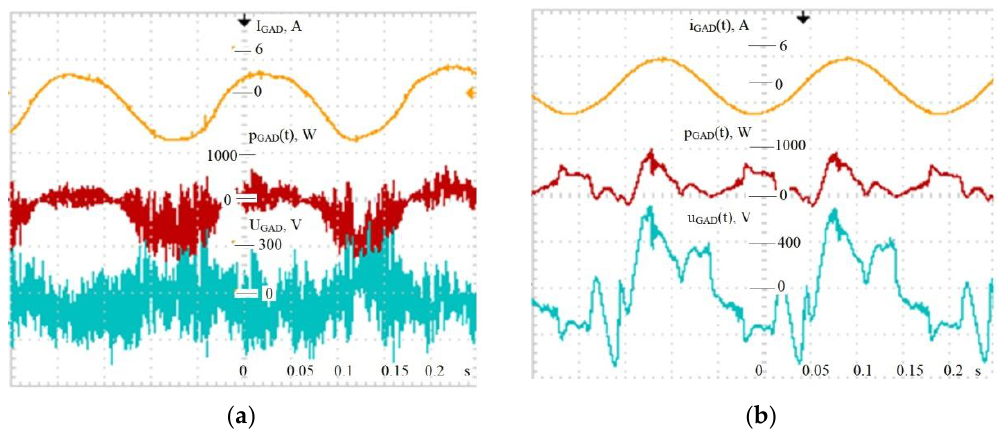
Figure 3. Oscillographs of electrode current I GAD , phase voltage U GAD and discharge power p GAD (t), when feeding the GAD reactor from transformers with cores made of: ( a ) Amorphous glass, ( b ) transformer sheet; on both oscillographs frequency of ignition voltage is equal to 20 kHz, process gas—Argon, flow rate 1 m 3 / h, RMS voltage U GAD = 250 V, RMS current I GAD = 2.2 A, supply voltage frequency f = 50